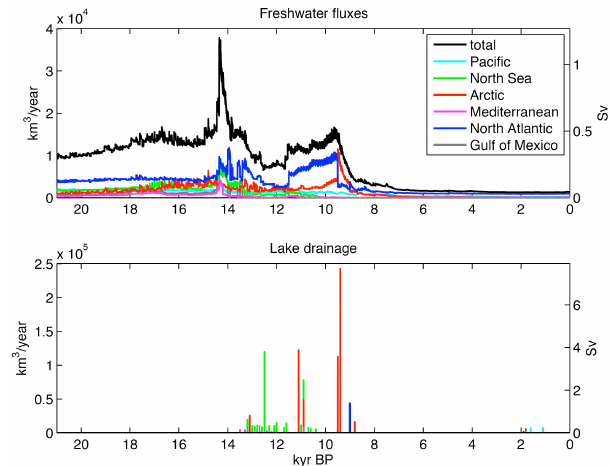
Figure 7: Freshwater contributions to different ocean basins (top) and lake drainage events 2 Fig. 7. Freshwater contributions to different ocean basins (top) and (bottom) for a transient deglaciation experiment. 3 lake drainage events (bottom) for a transient deglaciation experi-